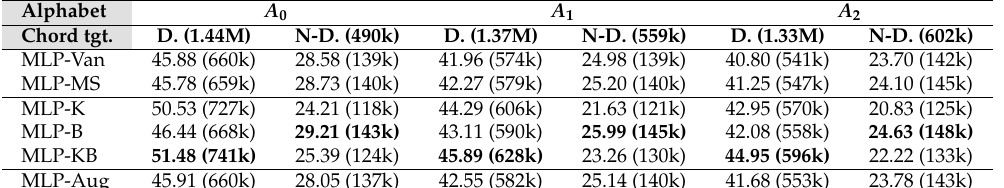
Table 8. Mean prediction accuracy for each method over the different chord alphabets on diatonic (D.) and non-diatonic (N-D.) chord targets. The amounts of associated items in the test dataset are in